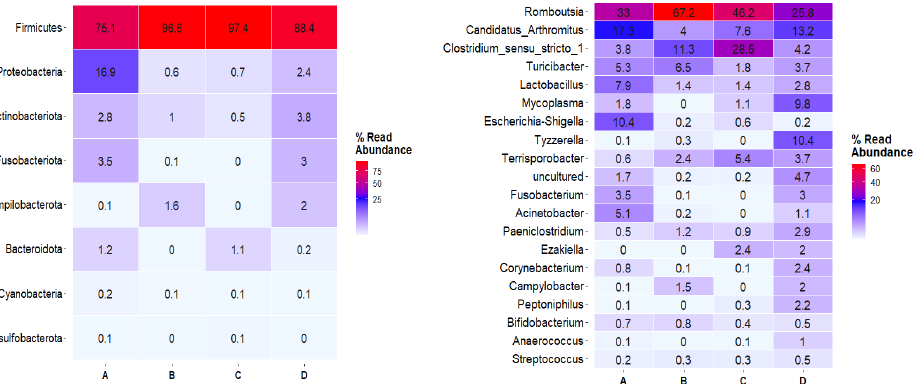
Figure 10. Heatmaps depicting the relative abundances of the major bacteria at the phylum (left) and genus (right) levels identified in each group. Numbers reflect the normalized relative abun- genus ( right ) levels identified in each group. Numbers reflect the normalized relative abundance (%) dance (%) within each group. within each